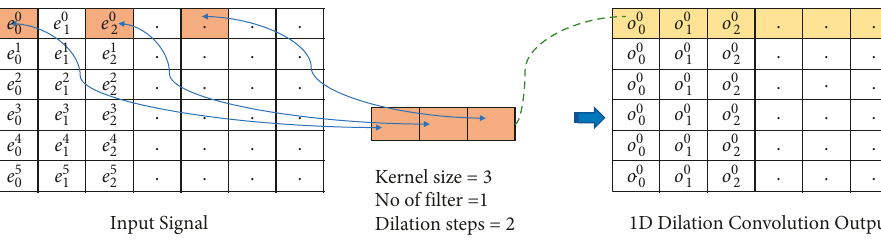
Figure 4: Example of one-dimensional dilated